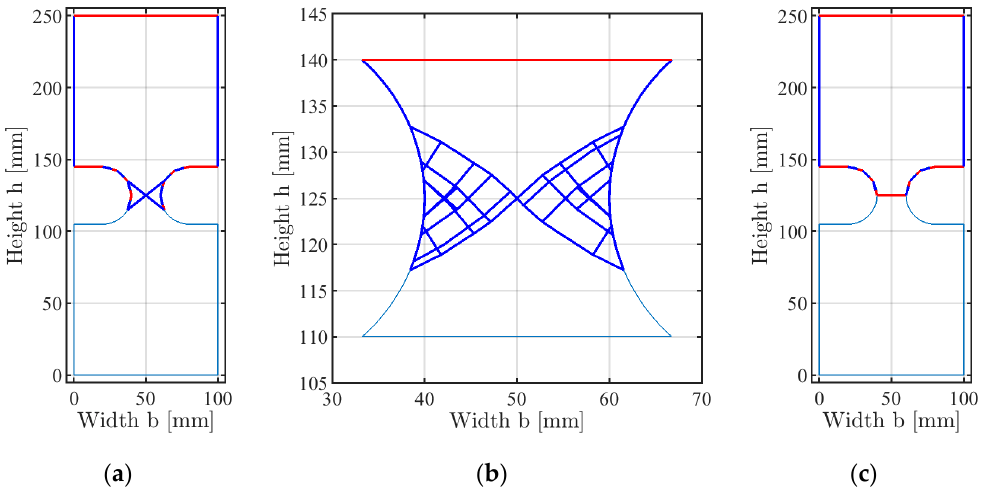
Figure 12. Collapse mechanisms (blue: Slip displacements, red: Normal displacements) from DLO for the tensile specimen with deep notches: ( a ) Slip line mechanism; ( b ) sub-model with refined slip line mechanism; ( c ) yield zone mechanism.